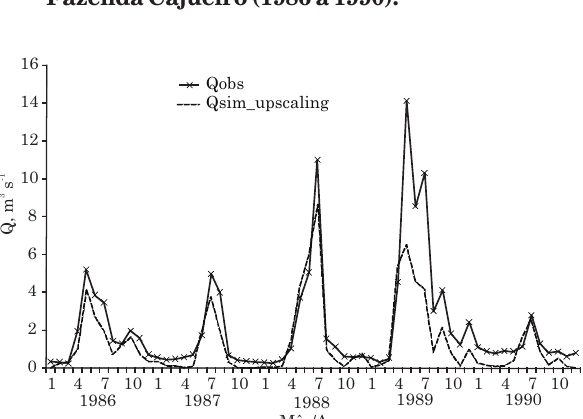
Figura 5. Hidrogramas observados (Qobs) e simulados para o posto Fazenda Cajueiro, com parâmetros calibrados (Qsim_ upscaling ) na Fazenda Pão de Açúcar (1986 a